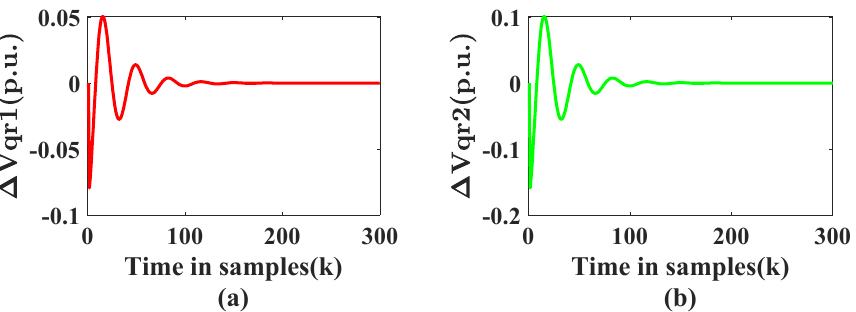
Figure 10. Control input signal ∆ V qr under the PSO-MPC strategy with wind turbines. ( a ) Control